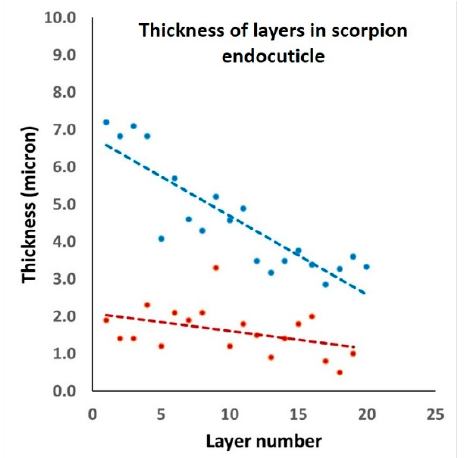
Figure 8. Plot of scorpion endocuticle layer thickness (blue symbols) against distance from the external side of the cylindrical cuticle (layer 1) down to its hollow core (layer 20). The much smaller interlayer thickness (red symbols, from 1 to 19) is plotted for comparison.